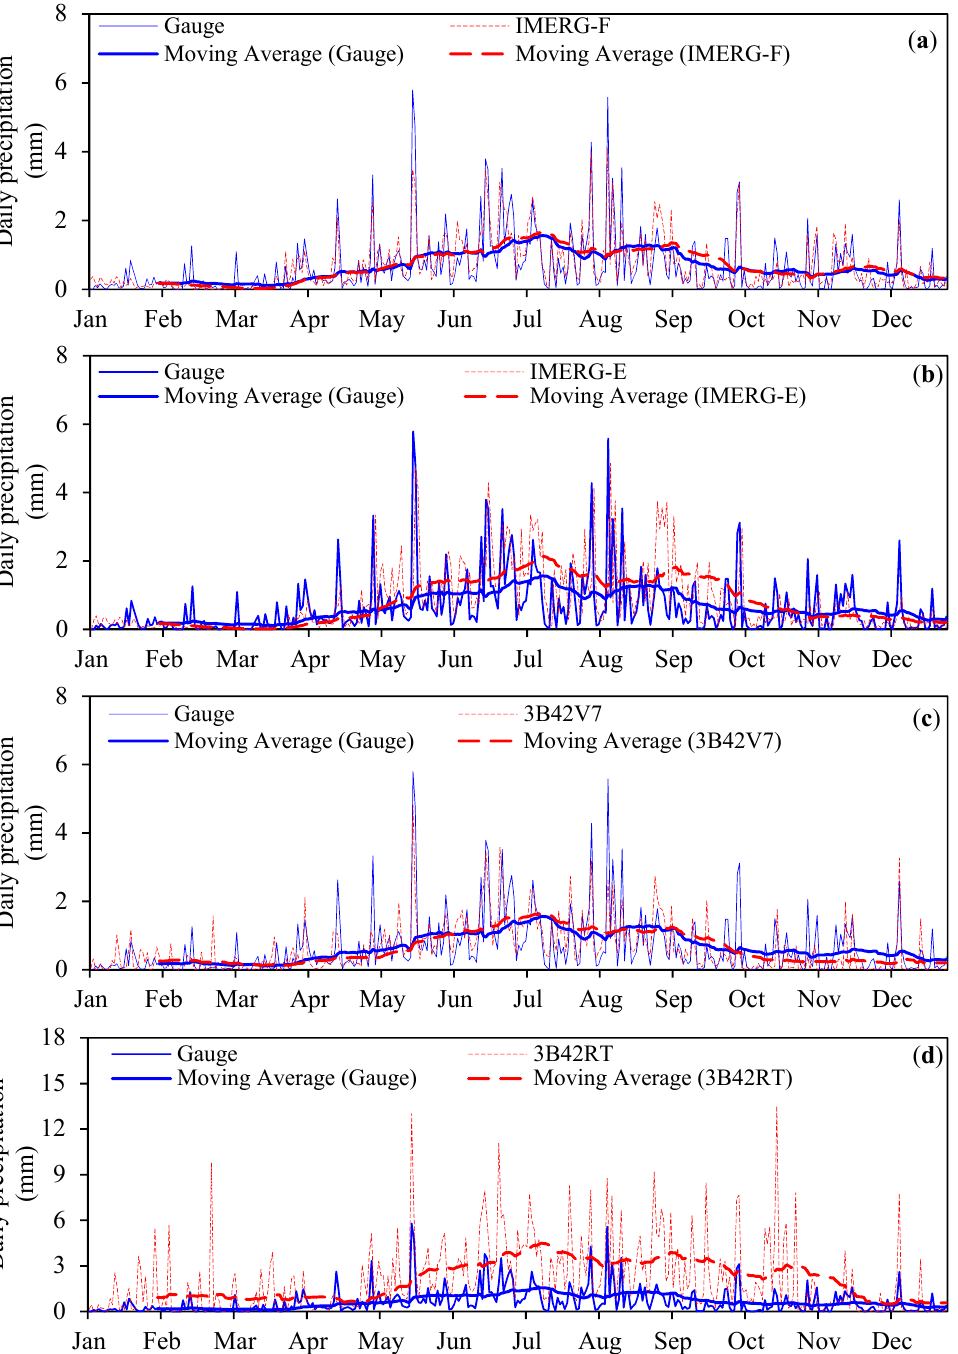
Figure 3. Comparison of the gauge-based average daily precipitation (during 2015 and 2016) with the average daily precipitation estimates from ( a ) IMERG-F, ( b ) IMERG-E, ( c ) 3B42V7, and ( d ) 3B42RT over the Tianshan Mountains. Thick blue and red (dashed) lines show the 30 days moving averages for gauge-based and satellite-based datasets.